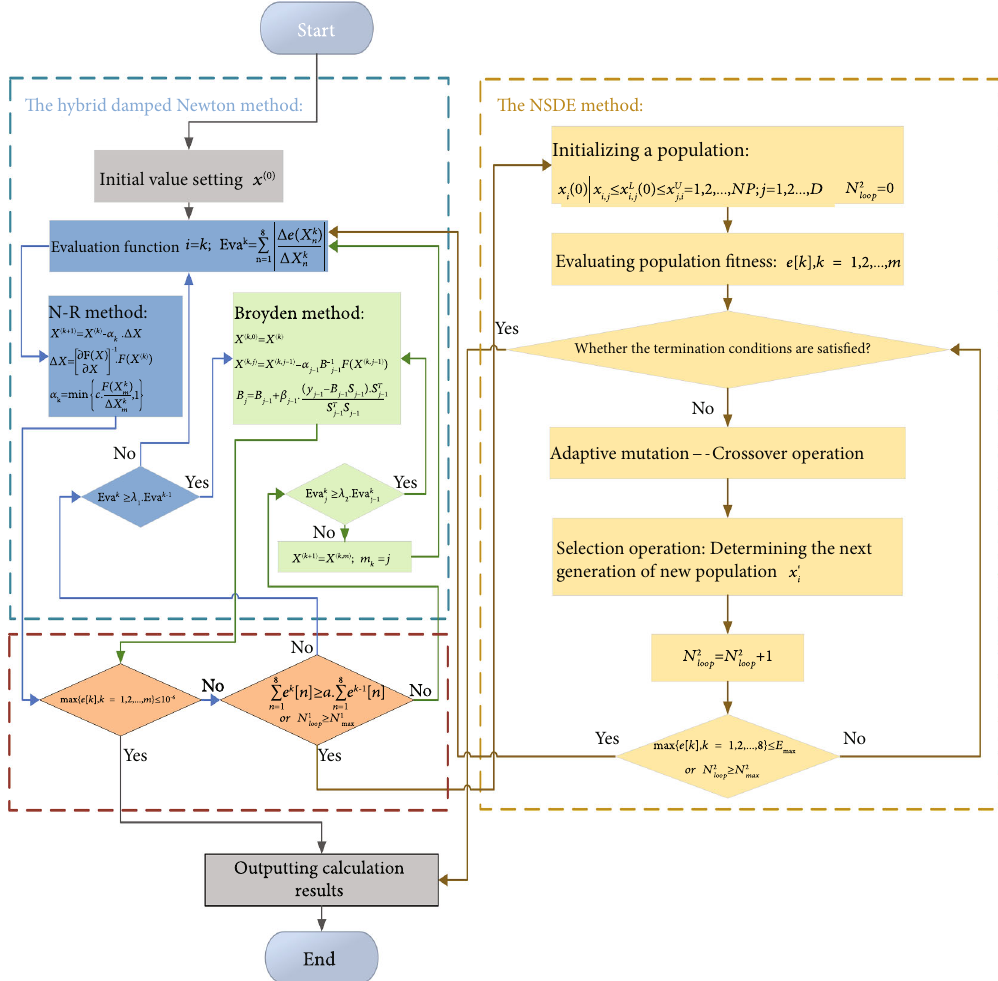
Figure 2: Basic fl owchart of the adaptive NSDE hybrid damping Newton